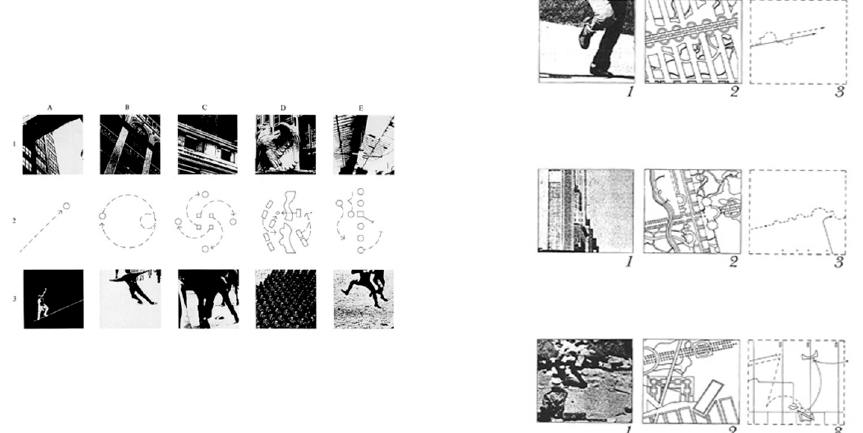
Figure 2. Bernard Tschumi’s Manhattan Transcripts provide the possibility of different interpretations of architecture through a set of disjunctions among use, form, and social values [42].